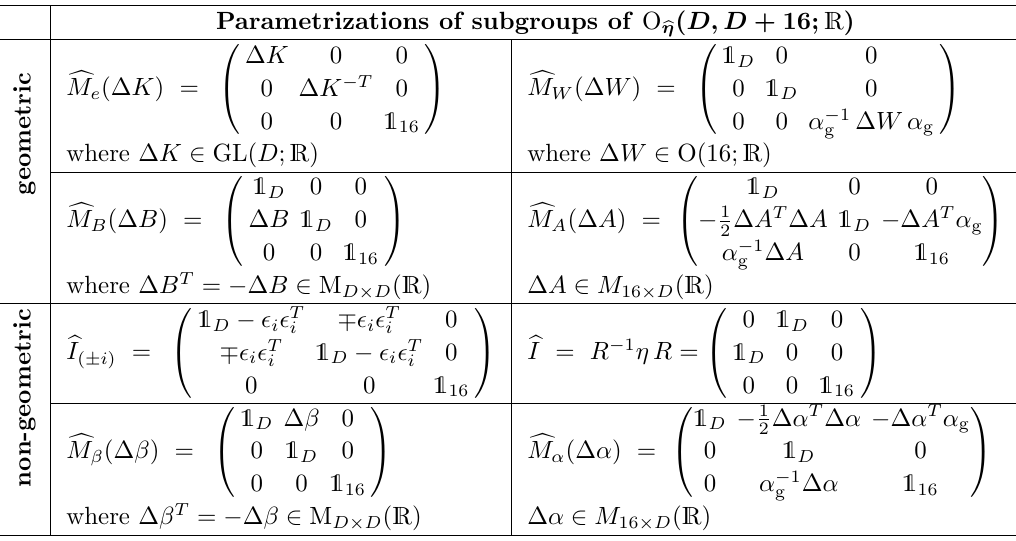
( D; D + 16; R ). b (cid:17)